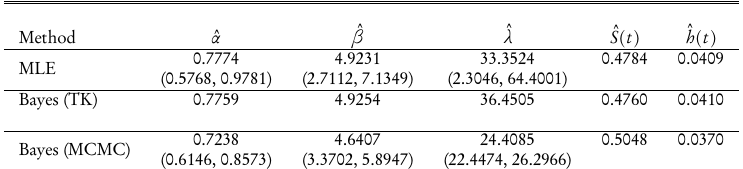
The ML and Bayes estimates of the parameters and reliability characteristics and 95% confidence / HPD credible interval estimates corresponding to the real data set of remission times (in weeks) of 30 leukemia